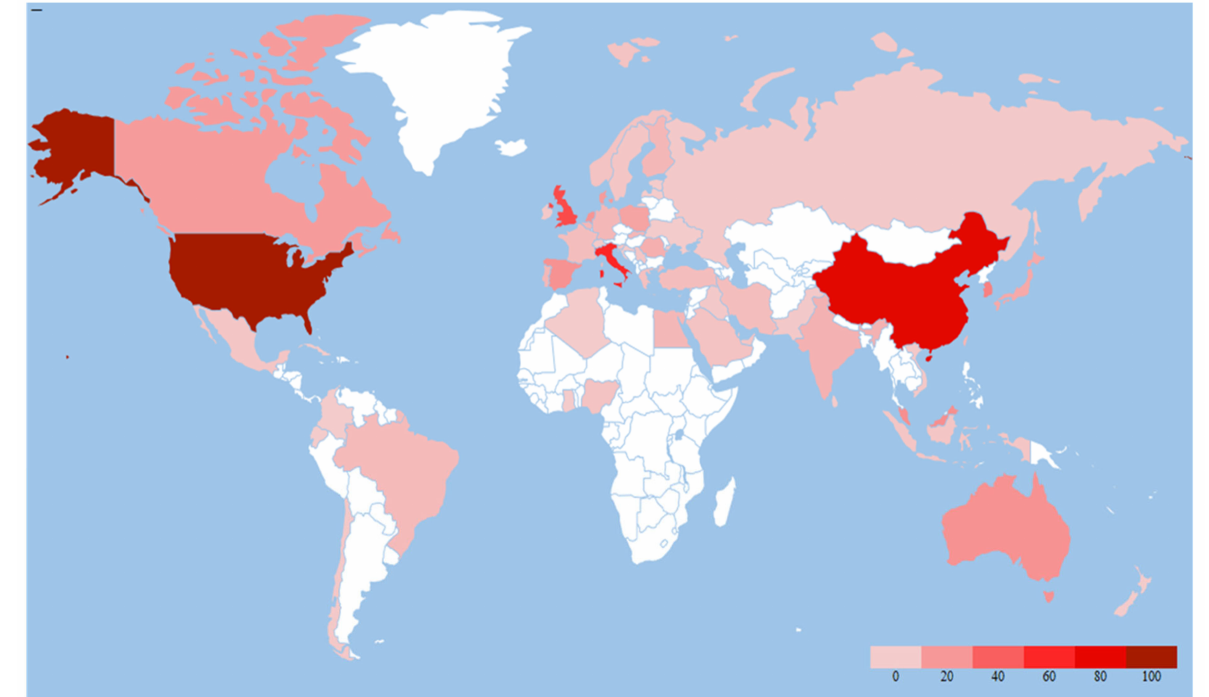
Figure 10. Network visualisation of main countries conducting research in the IEQMI